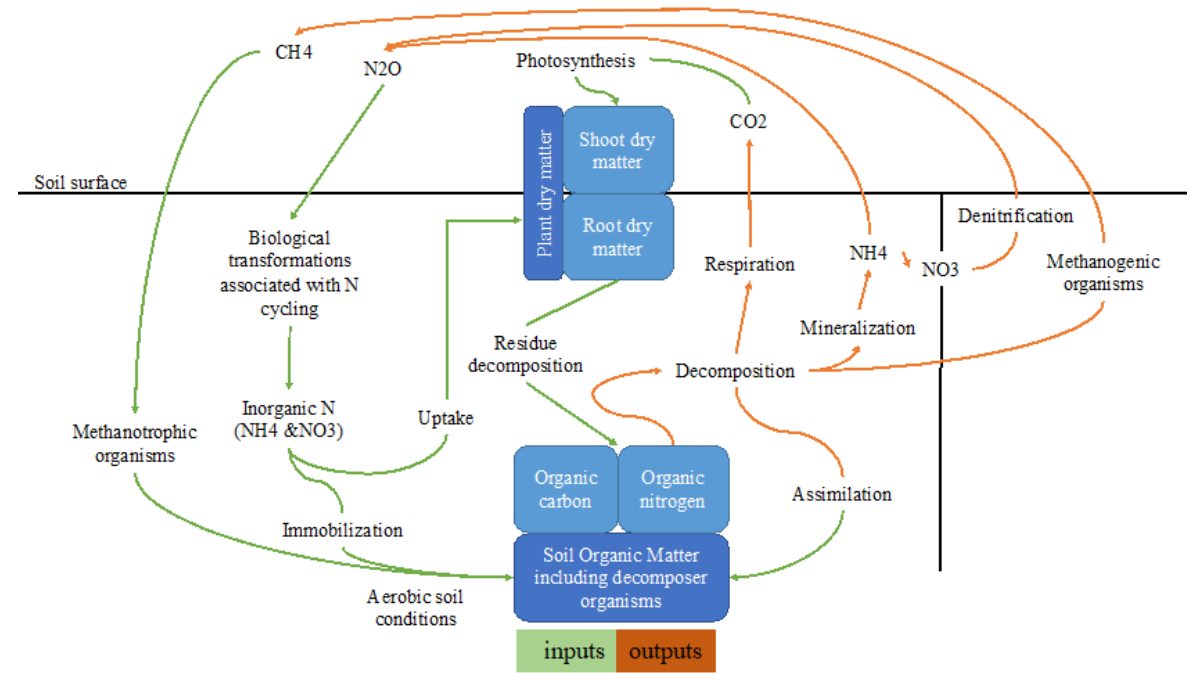
Figure 2. Soil biological processes that influence (inputs) utilizing of atmospheric gases into the soil and (outputs) GHG emissions from the soil into the atmosphere [34] .